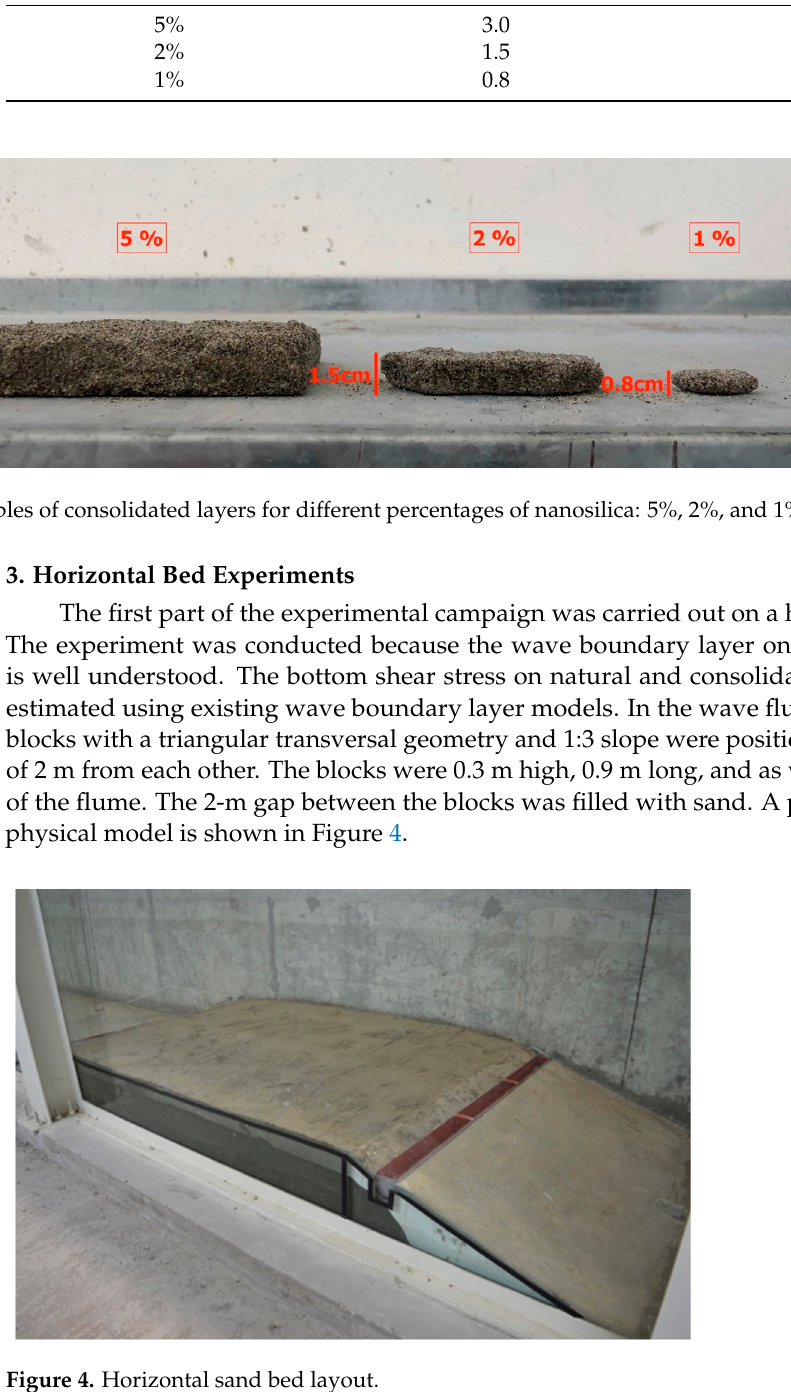
Table 1. Characteristics of consolidated layers of each percentage of nanosilica.